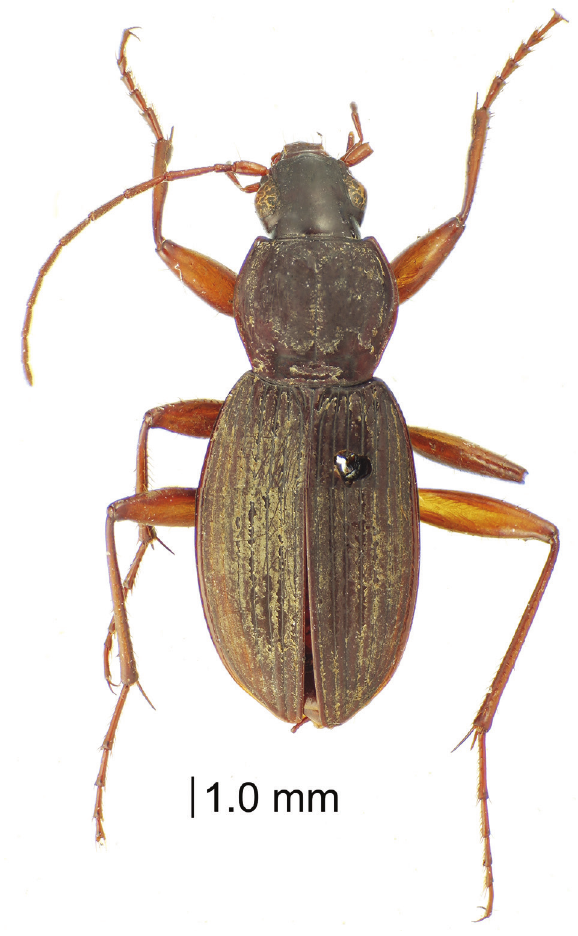
Figure 1. Male holotype, Bryanites graeffii , dorsal view.